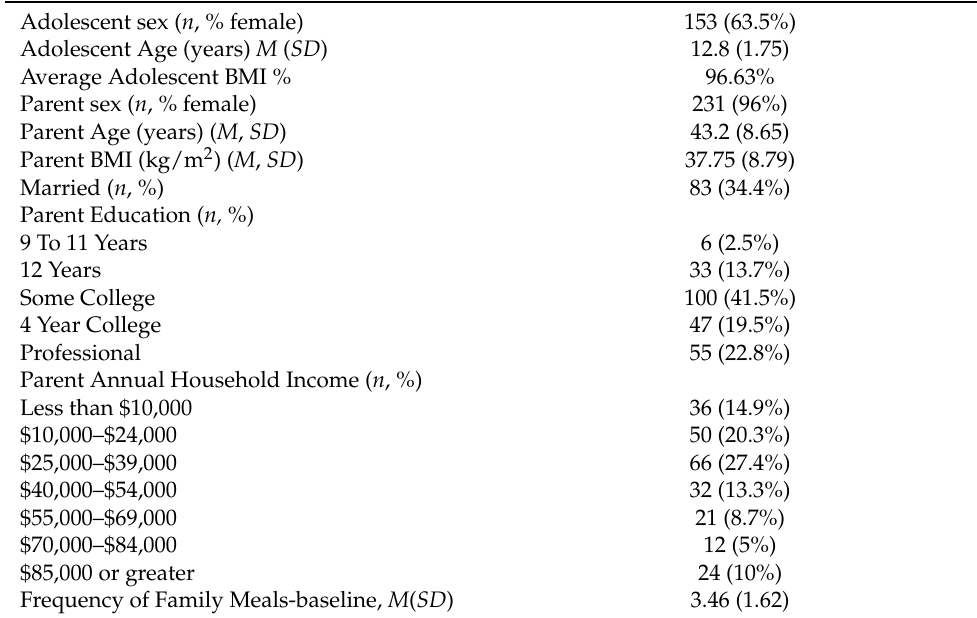
Table 1. Descriptive data for the total sample at baseline ( n =